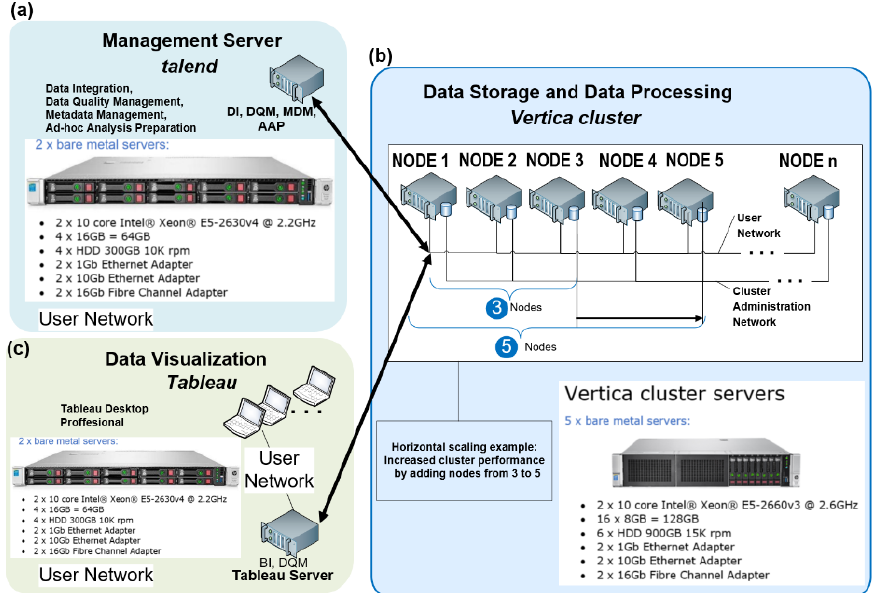
Figure 3. Resulting Big Data Analytics (BDA) platform: Architecture and infrastructure diagram showing the key components.